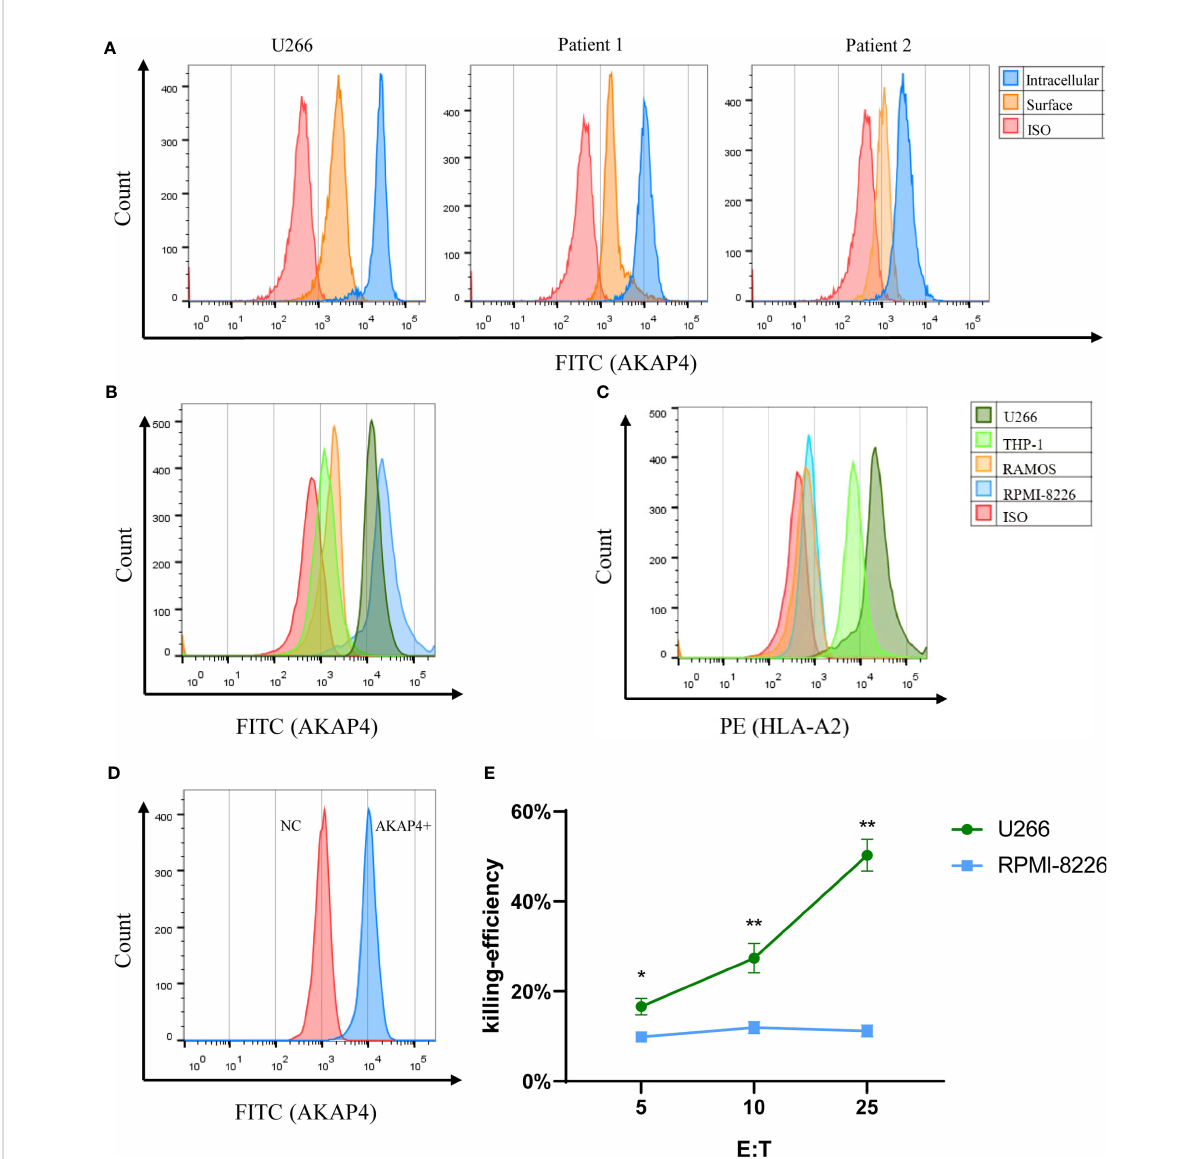
FIGURE 1 AKAP4 is expressed on primary MM cells and MM cell lines and induces speci fi c immune responses targeting myeloma cells. (A) AKAP4 was expressed both intracellularly and on the cell surface in primary cells of myeloma patients (gated on the CD38 + CD138 + population) and in myeloma cell line U266. (B) Intracellular expression of AKAP4 in different cell line. (C) Expression of HLA-A*0201 in different cell lines after IFN- g stimulation. (D) AKAP4 expression in DC cells of healthy donors after adenovirus transfection. (E) The killing effect of CTL on U266 cells (HLA- A 0201 + AKAP4 + ) induced by AKAP4 adenovirus transfection DC was higher than that of RPMI-8226 (HLA-A 0201 - AKAP4 + ) (summarized the results of three independent experiments). Friedman test showed the p < 0.05 for U266 and RPMI-8266. Then, the p -value was analyzed by Wilcoxon rank sum test. * p < 0.05, ** p < 0.01. NC: negative